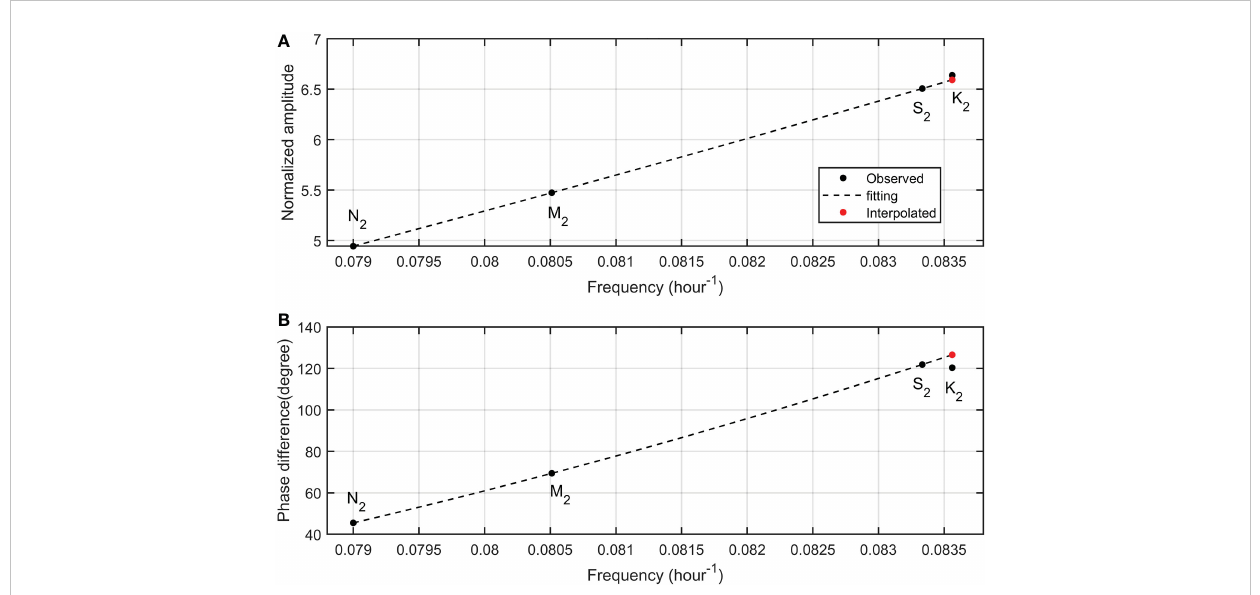
FIGURE 10 Same as Figure 6, but for surface tides at the mooring. Tidal constants are derived from EOT20